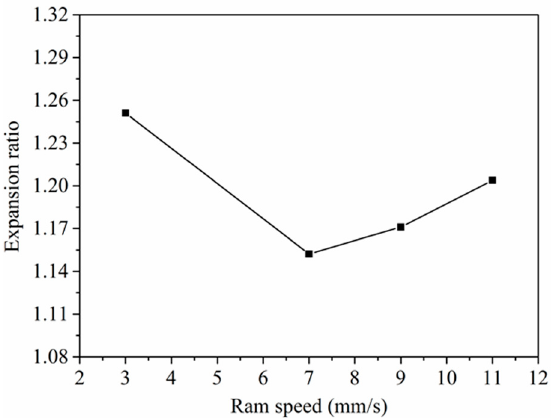
Figure 11. The relationship between the ram speed and expansion ratios.